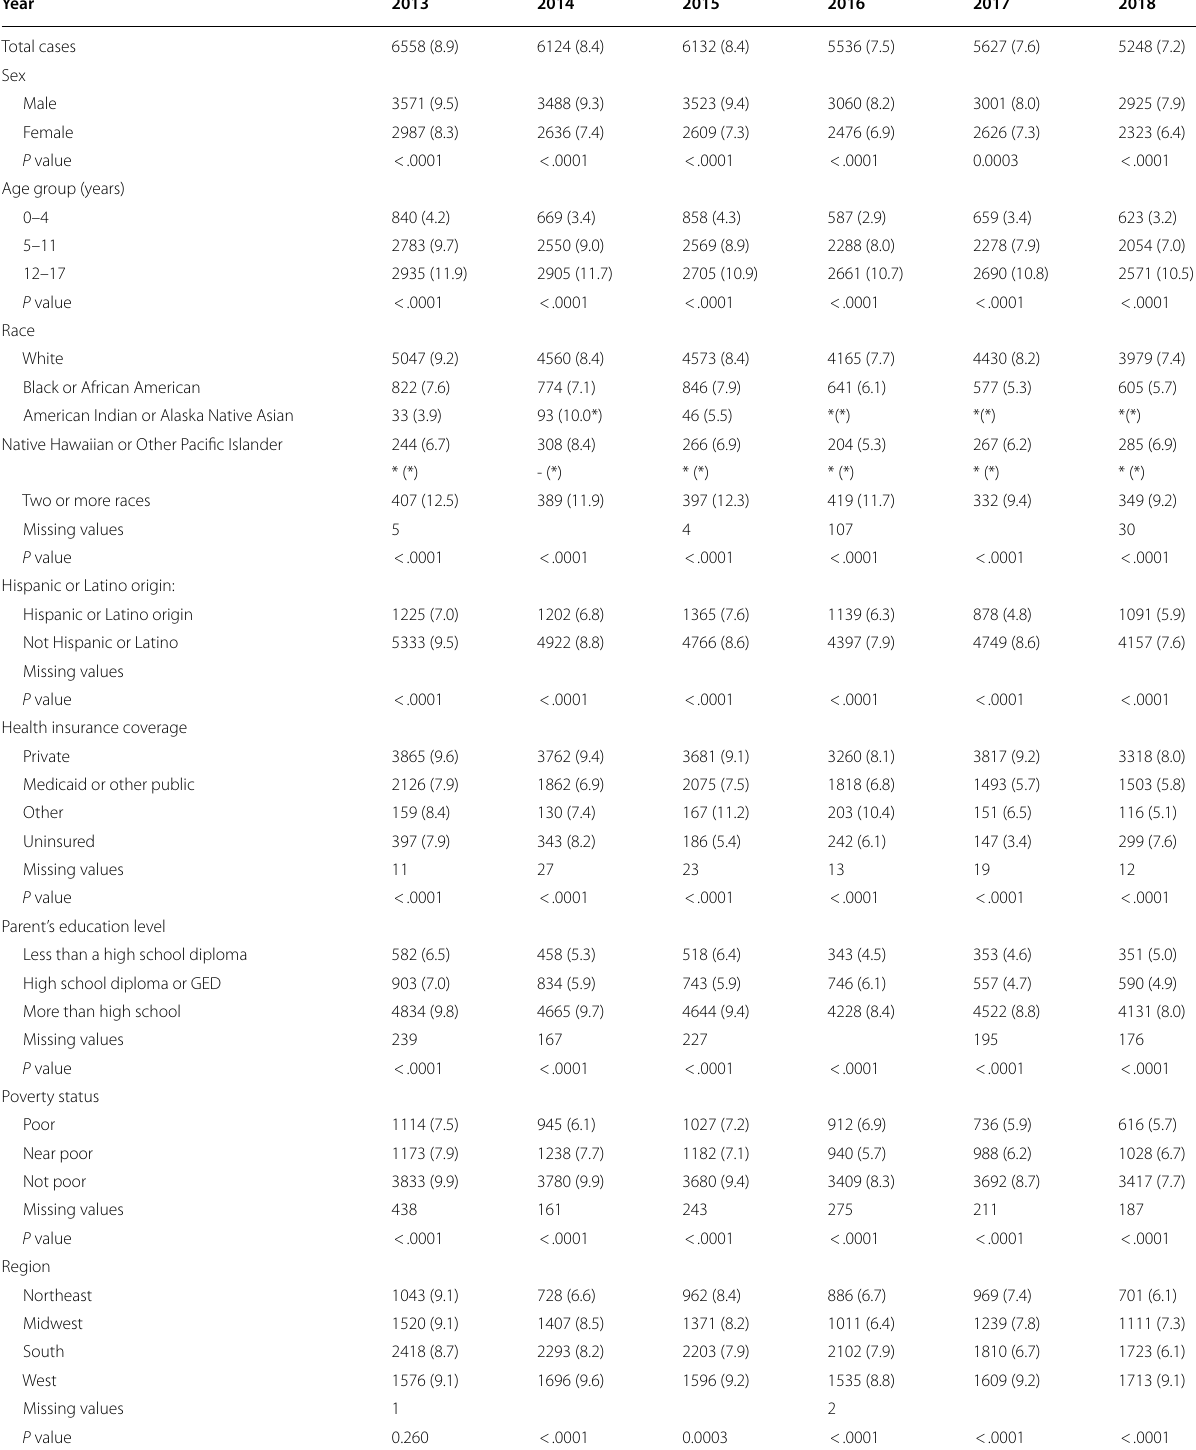
*Estimates are considered unreliable. Data preceded by an asterisk have a relative standard error (RSE) greater than 30% and less than or equal to 50% and should be used with caution. Data not shown have an RSE greater than 50% (according to the